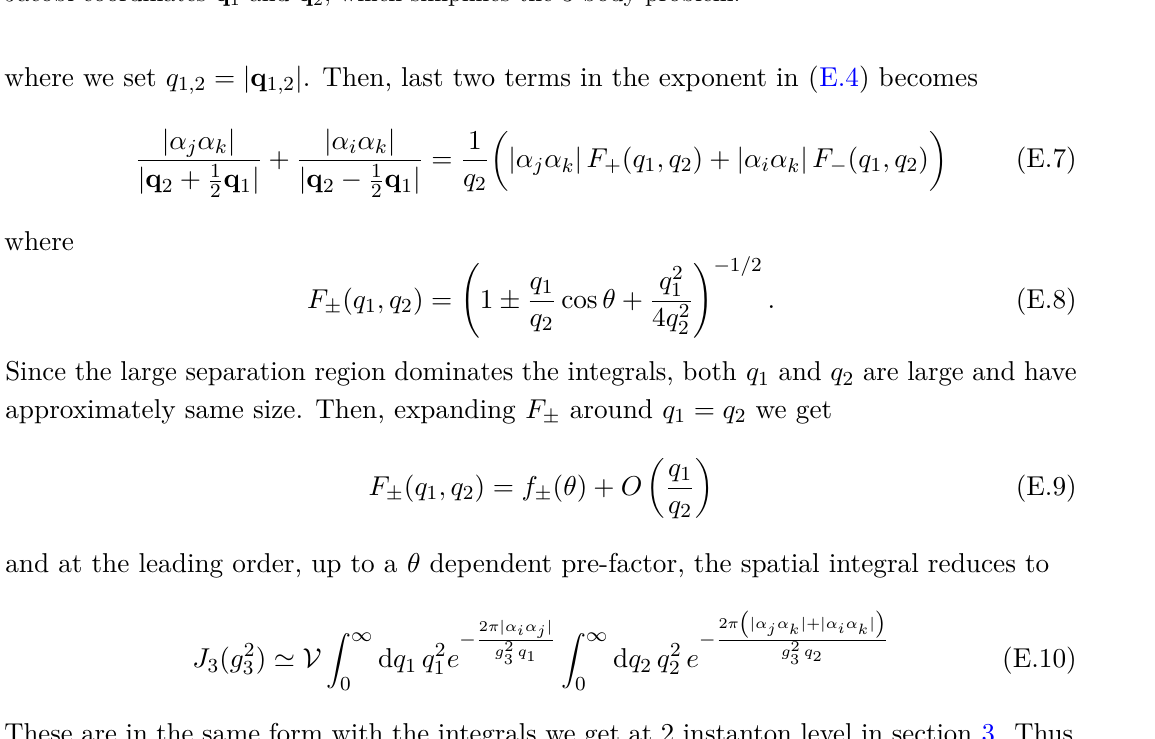
Figure 9 . Three monopoles located at r i , r j , r k . Their relative distances can be expressed by the Jacobi coordinates q and q , which simplifies the 3 body 1 2